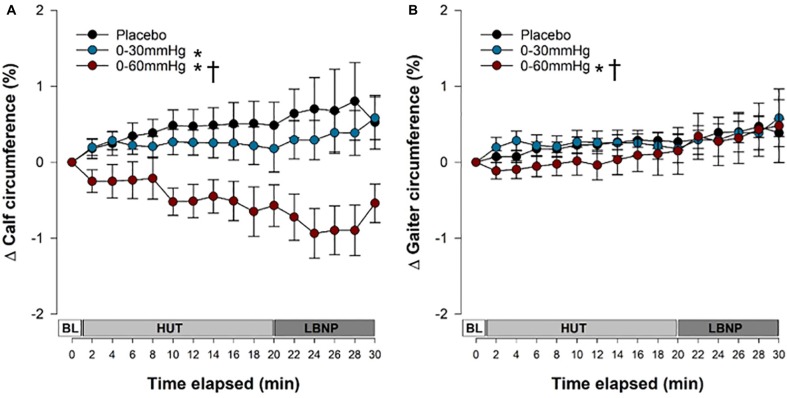
Venous pooling and capillary filtration during tilt testing. The time course of pooling and filtration in the calf (A) and at the level of the gaiter (B). Data are presented as a percentage change form supine and symbols (mean ± SEM) reflect mean data from the right and left calves/gaiters combined, from the final 30 s of every 2 min interval. Main effects of condition throughout tilt are shown. ∗Significantly different from placebo (p < 0.001); †Significantly different from 0 to 30 mmHg compression. BL, baseline; HUT, head-upright tilt; LBNP, lower body negative pressure.